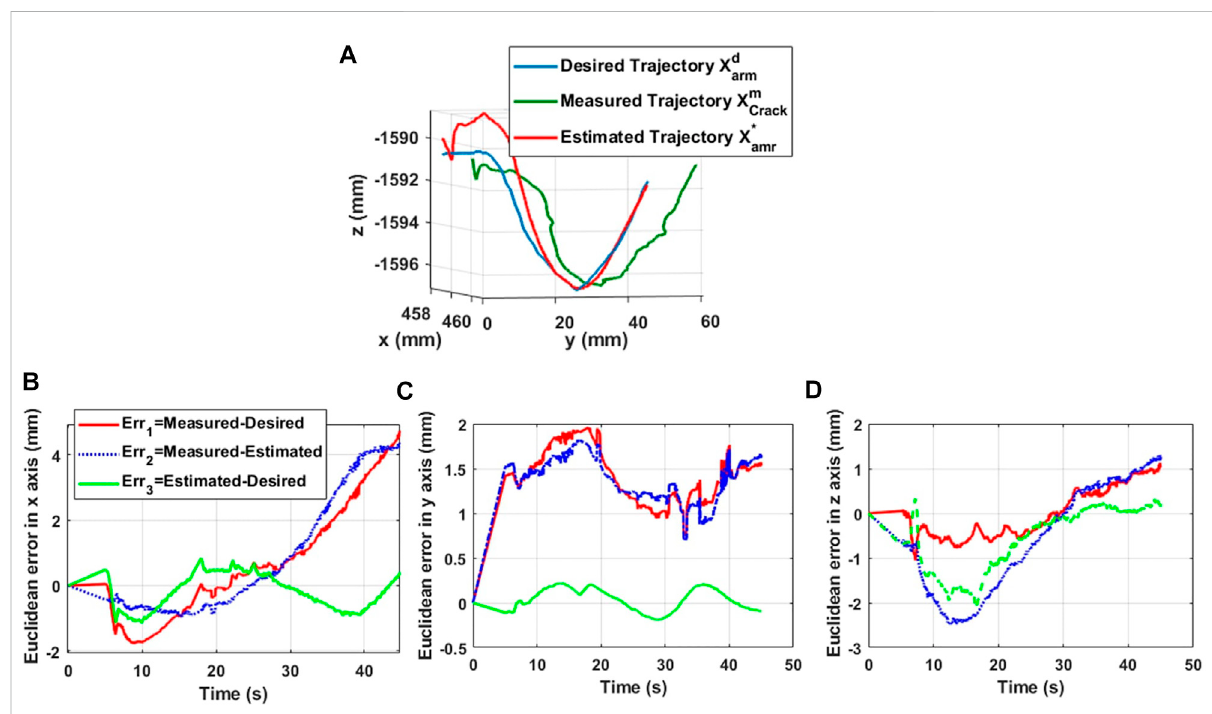
FIGURE 15 Trajectory of the tip of the arm during the reparation process of crack 2. (A) 3D position tracking of crack 2. (B) X -axis error. (C) Y -axis error. (D) Z -axis error.